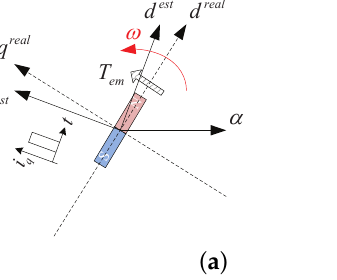
Figure 5. Rotor polarity detection based on torque pulse ( a ) when the estimated d est -axis aligns to the real d real -axis and ( b ) when the estimated d est -axis aligns to the opposite direction of real d real -axis.